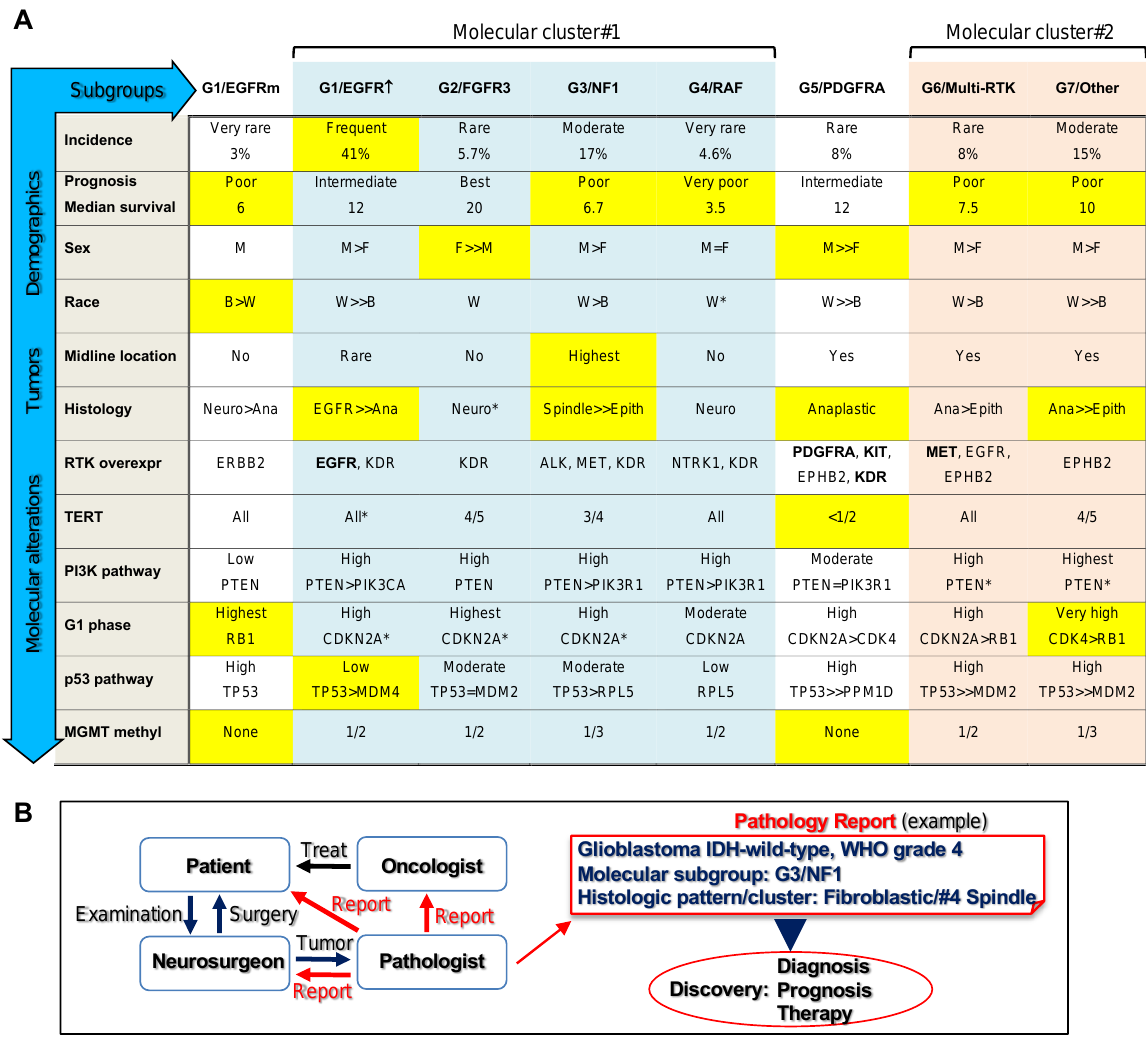
Figure 4. ERK/MAPK-based glioblastoma classification. ( A ) Multi-platform characterization of the IDH-wild-type glioblastoma G1 – G7 molecular subgroups showing main demographic, histologic, RTK expression, and growth pathway mutation analysis: light blue and peach shading indicate molecular cluster#1 and #2, respectively; yellow shading highlights some characteristic features of the subgroup. M, male; F, female; B, African-American/Black; W, Caucasian/White. The midline location comprises all midline structures including the corpus callosum. Histologic clusters: Neuro, Small neuronal; Ana, Anaplastic; Epith, Epithelioid. RTK overexpression (overexpr) shows the most commonly upregulated RTKs; in bold are RTKs with gene amplifications. The mutation frequency is considered: highest, 100% cases; very high, >90% cases; high, ≥ 66.7% cases; moderate, between 33.3% and 66.7% cases; low, ≤ 33.3% cases. Asterisks (*) mark the presence of other minor components within the subgroup when only one parameter is shown. ( B ) Implementation of the glioblastoma classification in clinical practice and discovery. Schematic flowchart shows the management of the glioblastoma patient by the brain tumor team. An example of pathology report is shown, with incorporation of the glioblastoma molecular subgroup and histologic pattern and cluster.